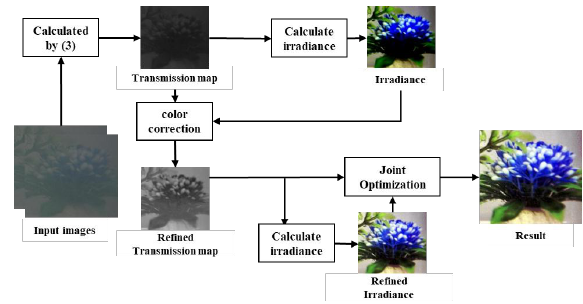
Figure 2. The illustration of the proposed